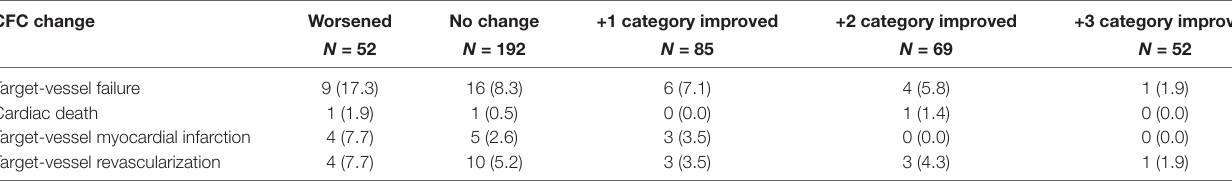
TABLE 4 | Associations of CFC changes following PCI in ranks and detailed outcomes. CFC